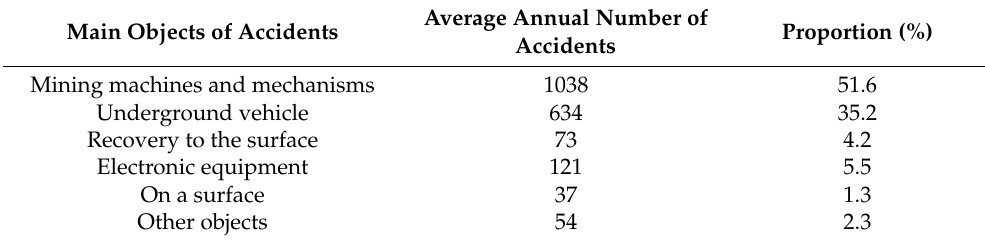
Table 1. Classification by objects leading to accidents at Russian coal enterprises. Main Objects of Accidents